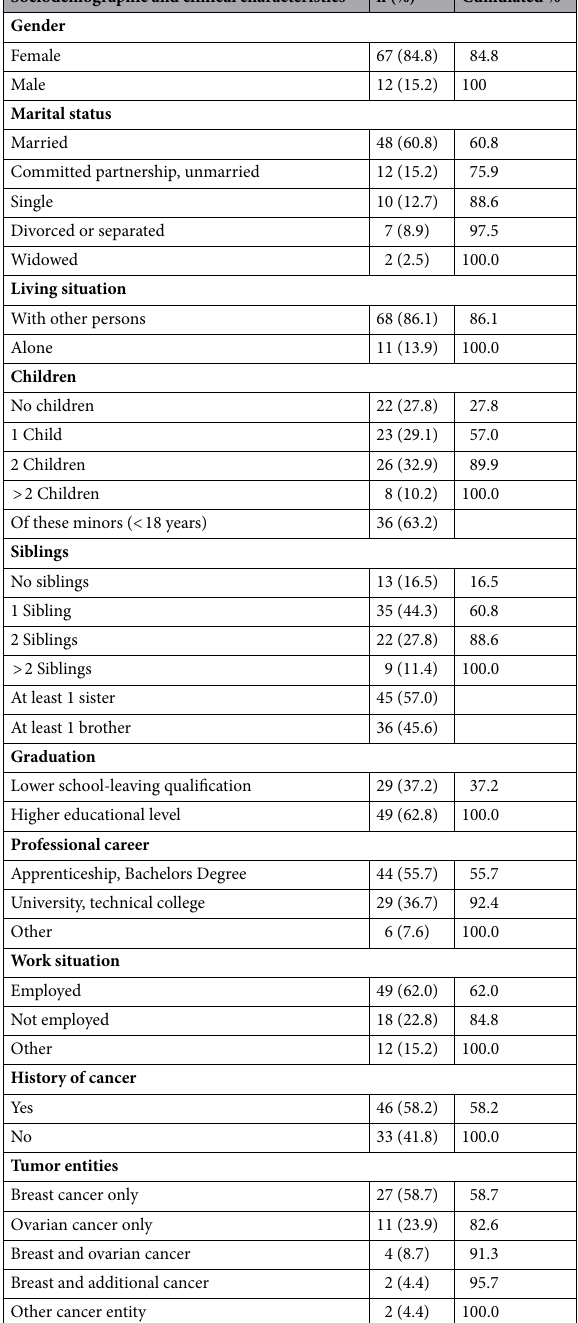
Table 1. Sociodemographic and clinical characteristics of the